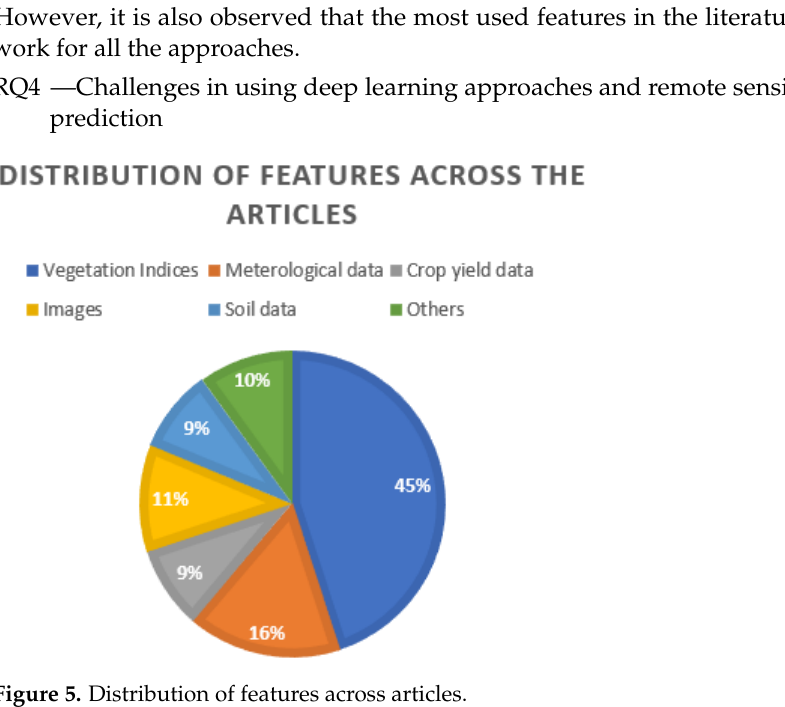
Figure 5. Distribution of features across articles.